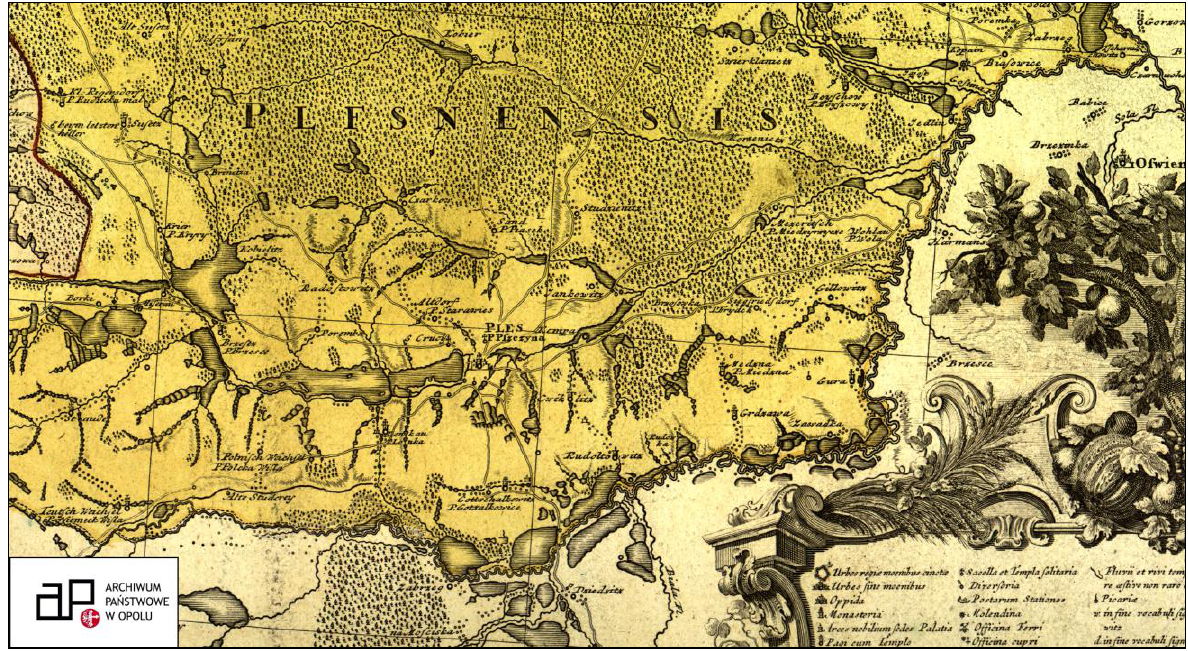
Fig. 4. Pond complexes and the layout of the surface hydrographic network in the River Little Vistula valley in the first half of